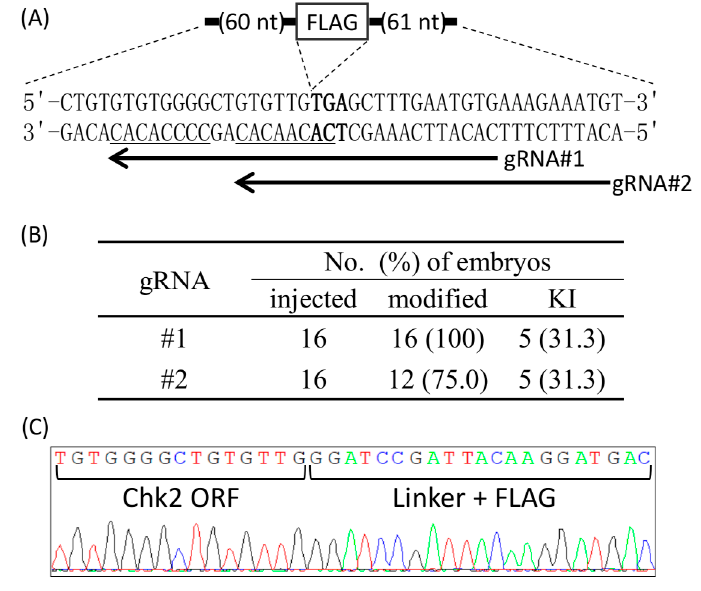
Figure 2. Zygote-mediated KI at the C-terminal region of Chk2 using Cj-CRISPR/Cas. ( A ) Schematics of the target sequence. Arrows and underlined sequences indicate the target loci of each gRNAs and its PAM, respectively. The stop codon of Chk2 is shown in bold. The DNA sequence of ssODN is shown in Table S1. ( B ) Generation efficiencies of genome-modified embryos. ( C ) Waveform data of the target locus from an embryo modified using gRNA #2. ORF: open reading frame, FLAG: DYKDDDDK epitope tag sequence.